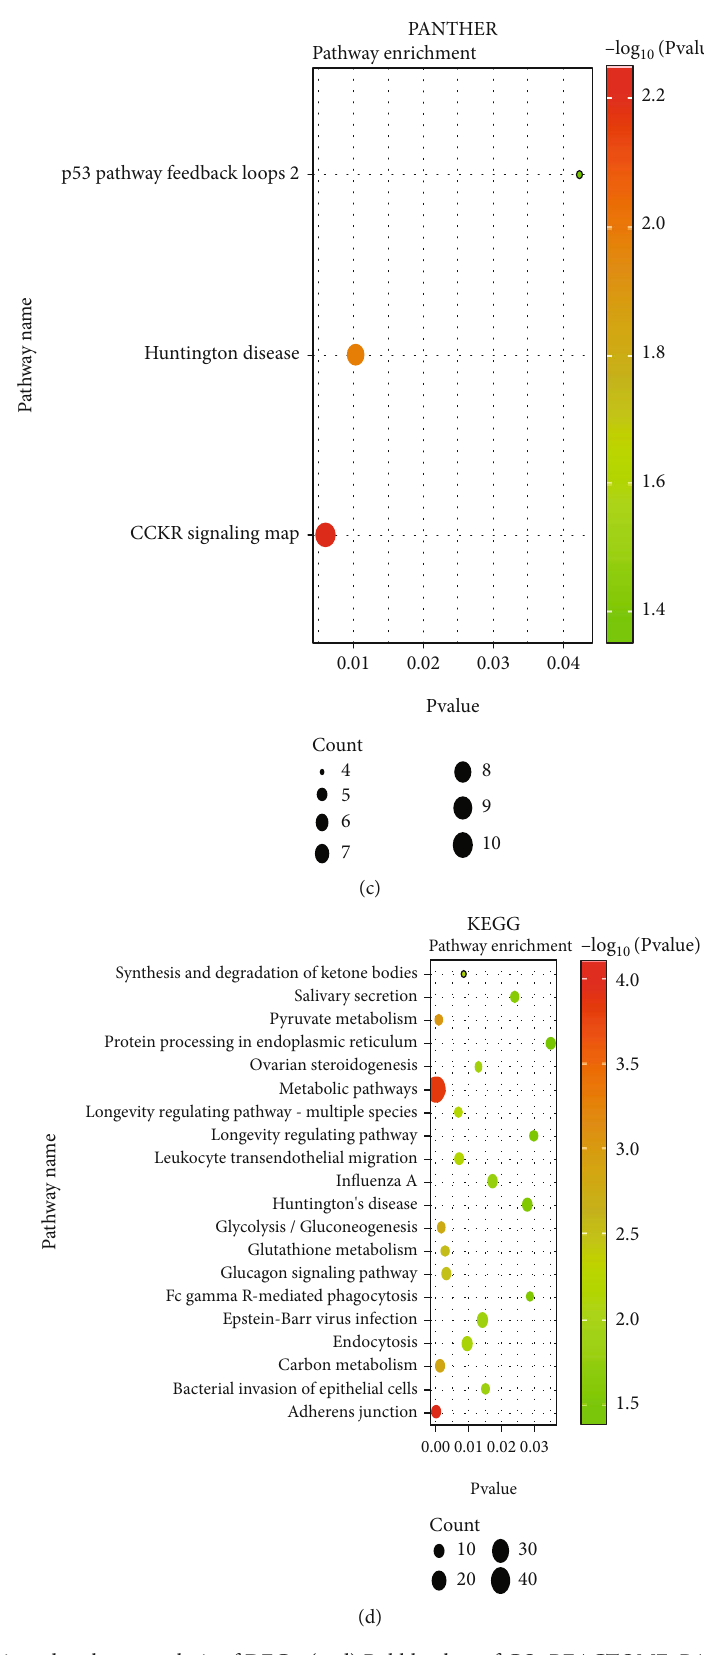
Figure 2: Function analysis and pathway analysis of DEGs. (a – d) Bubble plots of GO, REACTOME, PANTHER, and KEGG